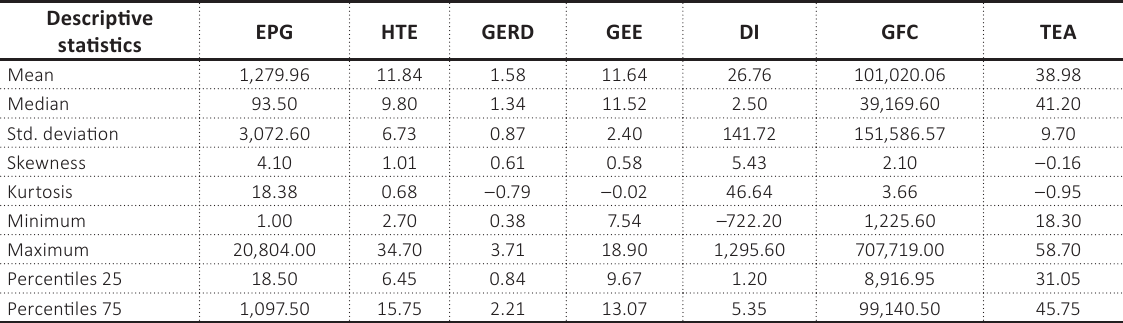
Table 3. Descriptive statistics of the selected innovation